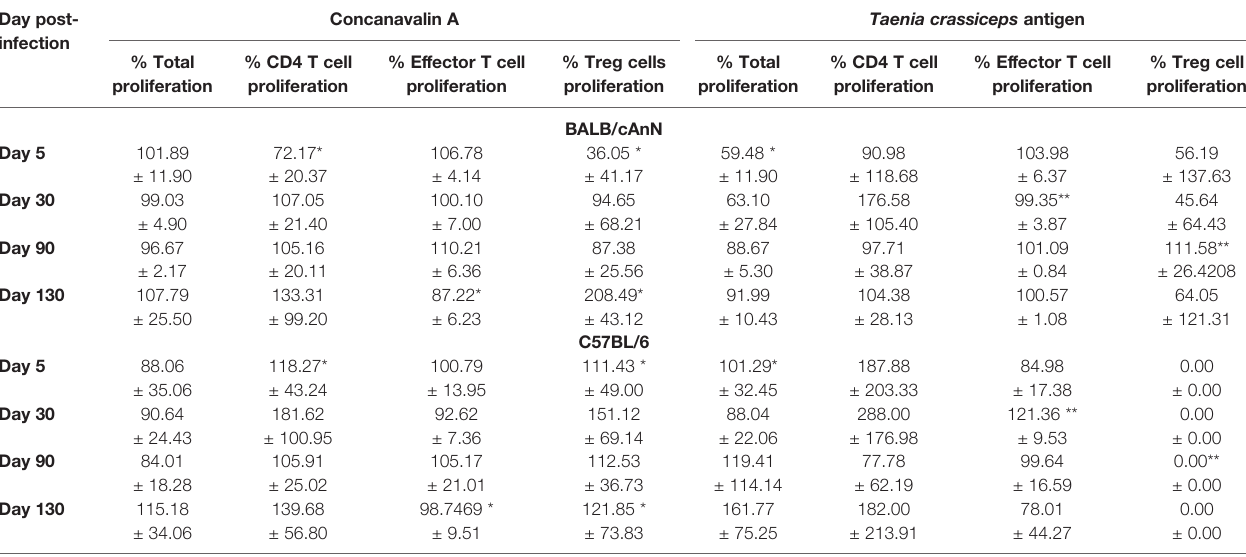
TABLE 1 | Proliferative immune response of spleen cells against non-speci fi c and speci fi c antigens in susceptible (BALB/cAnN) and non-susceptible (C57BL/6) mice. Day post- Concanavalin A Taenia crassiceps infection